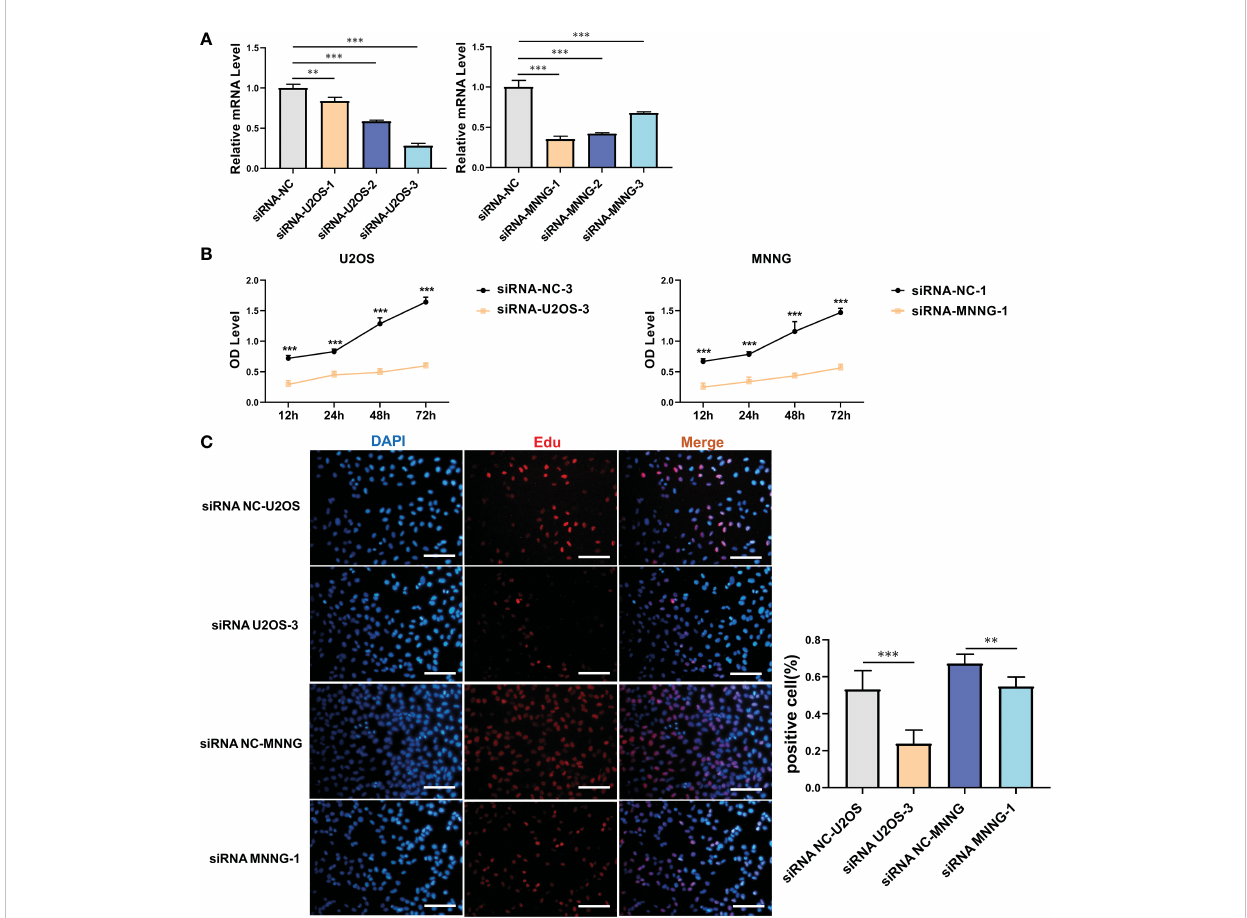
FIGURE 4 In vitro validation on SERPINH1. (A) RT-qPCR results of the expression of SERPINH1 in four groups (si-NC, si-SERPINH1-1, si-SERPINH1-2, si-SERPINH1- 3) in two cell lines. (B) CCK-8 assay in two groups (si-NC, si-SERPINH1). In two cell lines, (C) EdU assay in two groups (si-NC, si-SERPINH1). **P<0.01;